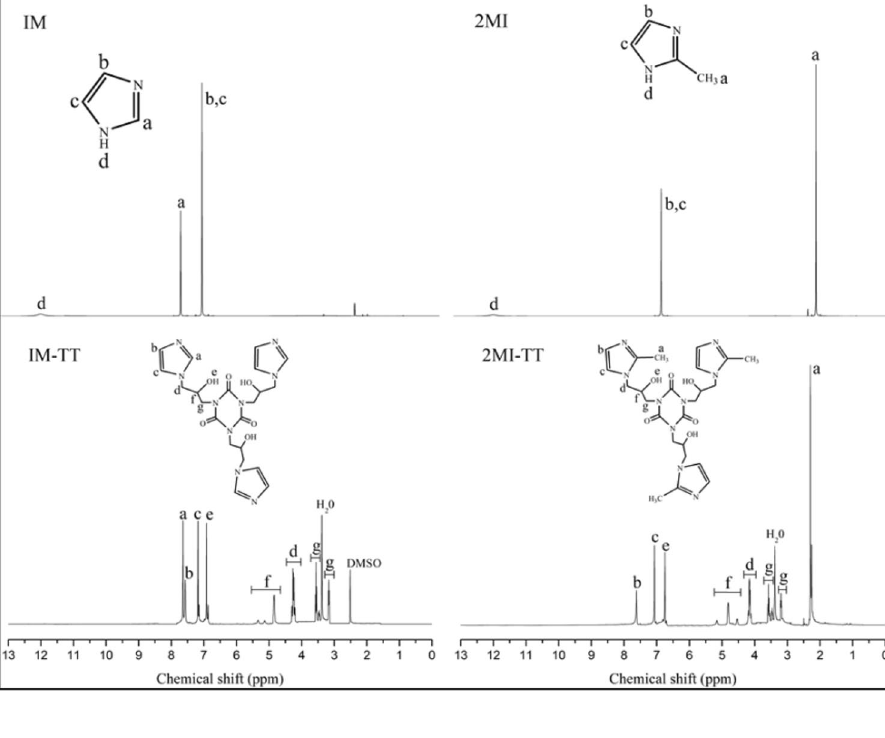
Fig. 3 1 H NMR spectra of 2EI, EMI, 2EI-TT and